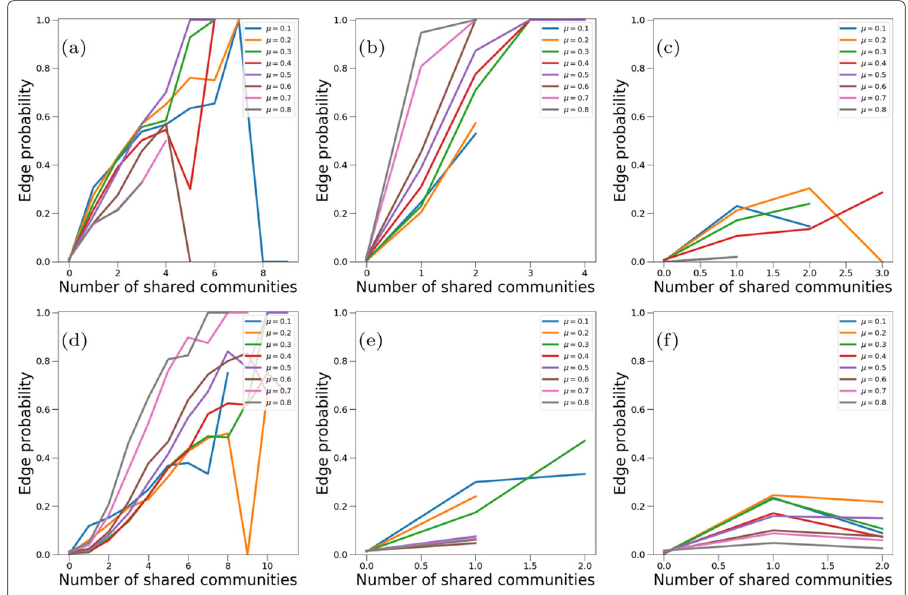
Fig. 24 Variation of mixing parameter ( μ ) for LFR synthetic networks considering the edge probability: a Bigclam; b CFinder; c Copra; d Demon; e SLPA; f